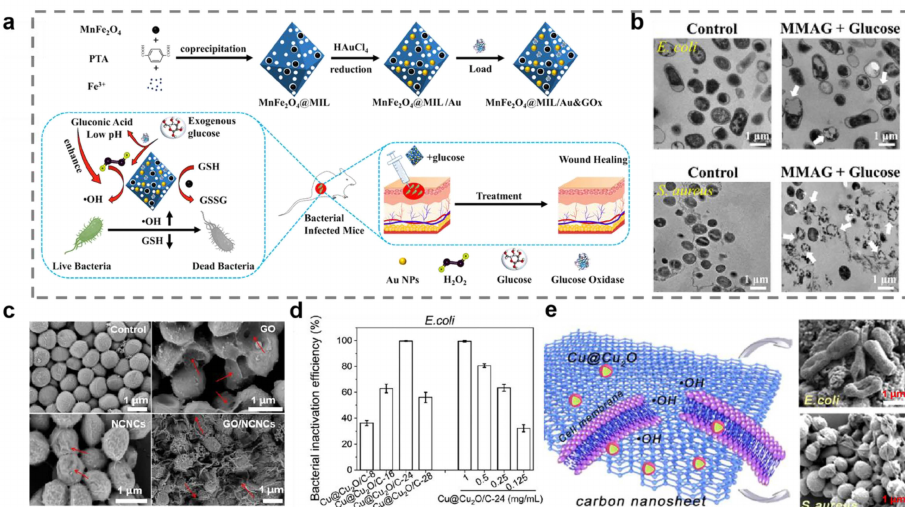
Figure 4. Cell membrane damage caused by reactive oxygen species and sharp edges. ( a ) The preparation process and antibacterial mechanism of MnFe 2 O 4 @MIL/Au&GOx (MMAG). ( b ) Trans- mission electron microscope image of bacterial morphology. White arrows represent serious damage of bacterial cells. ( c ) The bacterial morphological changes with different treatments assessed by scanning electron microscope. Red arrows represent serious damage of bacterial cells. GO, graphene oxide; NCNC, nickel colloidal nanocrystal cluster. ( d ) Evaluation of antibacterial properties of carbon nanosheets decorated with core-shell Cu@Cu 2 O nanoparticles (Cu@Cu 2 O/C-24). ( e ) Schematic diagram of the antibacterial mechanism of Cu@Cu 2 O/C-24 under the dark condition. ( a , b ) Reprinted with permission from Ref. [74]. Copyright 2022 American Chemical Society. ( c ) Reprinted with per- mission from Ref. [77]. Copyright 2022 American Chemical Society. ( d , e ) Reprinted with permission from Ref. [79]. Copyright 2021 American Chemical